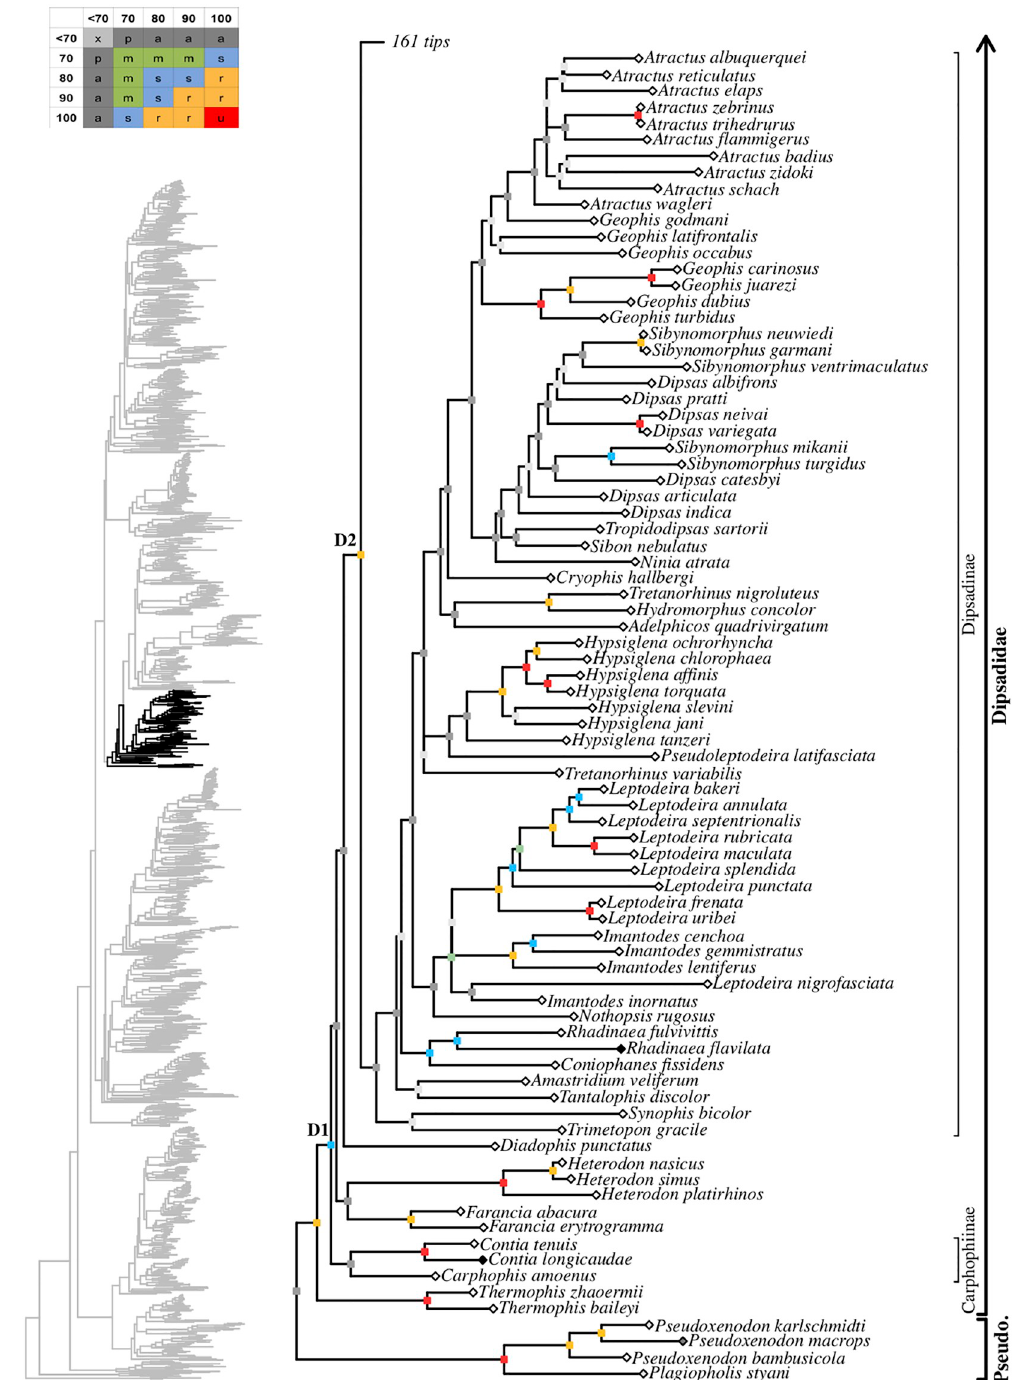
Fig 15. Maximum likelihood species-level phylogeny of Colubroides (continued). Families Pseudoxenodontidae and Dipsadidae.